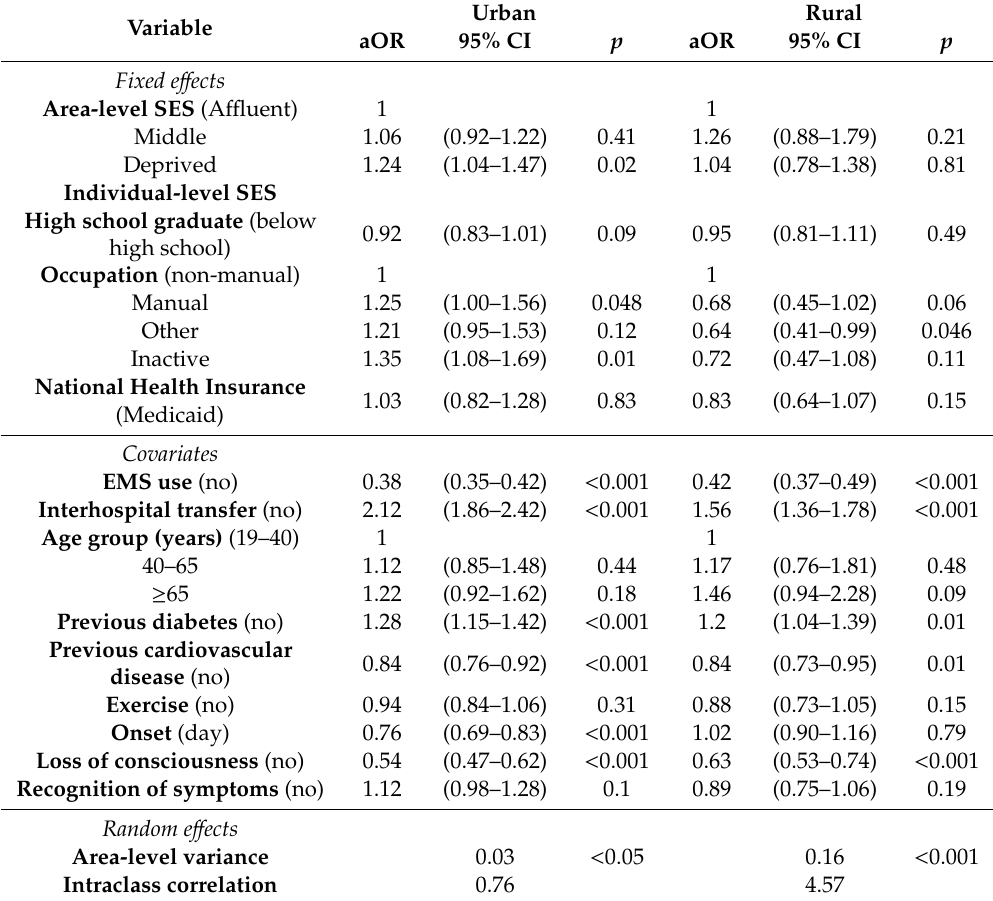
Table 4. Multivariate logistic regression analysis of prehospital delay stratified by urbanization